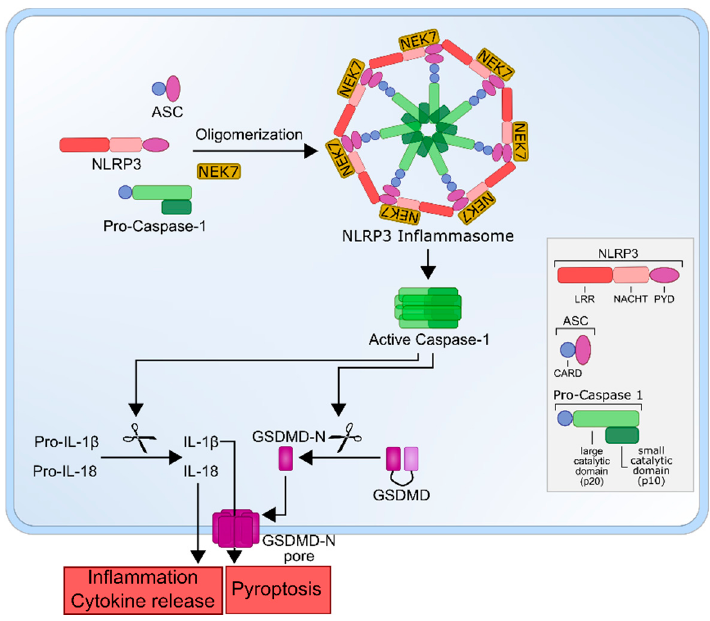
Figure 1. The NLRP3 inflammasome. Oligomerization of NLRP3, ASC and pro-caspase 1 into an active NLRP3 inflammasome leads to caspase-1 activation, which cleaves pro-interleukin-1 β (IL-1 β ) and pro-IL-18 into their active forms, IL-1 β and IL-18. Biologically active IL-1 β and IL-18 exit the cell and cause inflammation. Additionally, GSDMD is cleaved by capsase-1, whereupon its amino-terminal end forms a transmembrane pore, leading to pyroptosis. NLRP3, NOD-like receptor protein 3; ASC, apoptosis-associated speck like protein; NEK7, NIMA-related kinase 7; GSDMD, Gasdermin-D; GSDMD-N, GSDMD amino-terminal cell-death domain; LRR, leucine-rich repeat; PYD, pyrin domain and CARD, caspase activation and recruitment domain.